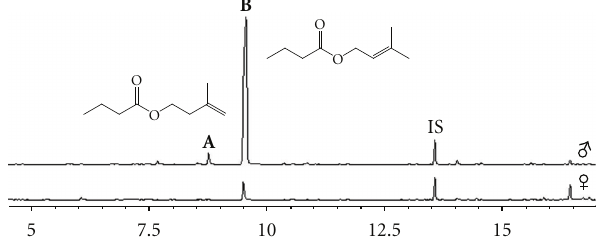
Figure 4: Representative gas chromatograms of body extracts of 21-day-old Thaumastocoris peregrinus (Heteroptera, Thaumas- tocoridae) males and females. Minor and major compounds, 3-methylbut-3-en-1-yl butyrate ( A ) and 3-methylbut-2-en-1-yl butyrate ( B ), respectively. The internal standard (IS) was tridecane; extracts shown here were analyzed on GCMS-QP 2010